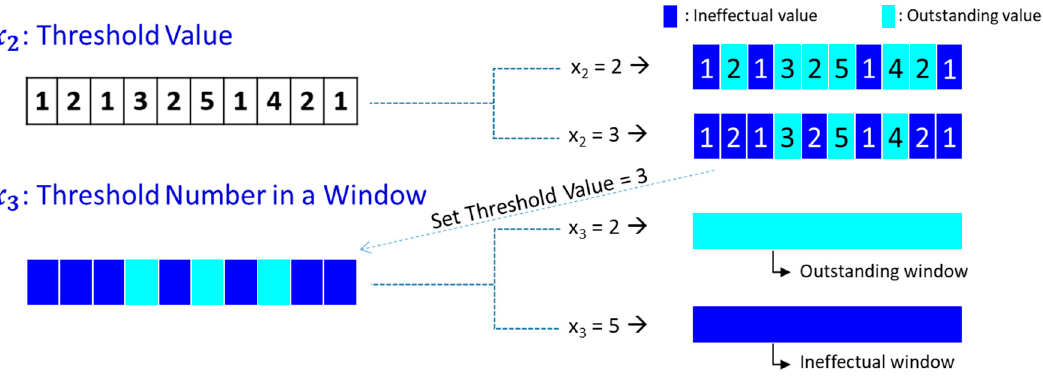
Figure 4. Example of design variables: x 2 = threshold value for parameter to be outstanding, and x 3 = threshold number of outstanding parameters for a window to be outstanding .